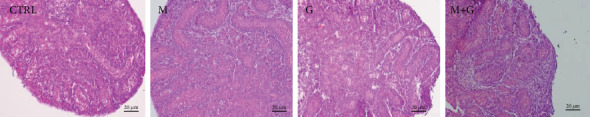
H&E staining of fetal testis cultured for 4 days. H&E staining showed an intact testicular structure and normal appearance of seminiferous tubules; no apparent necrosis or vacuole was visible in all groups; formation of tubular lumens was still not observed. 200x magnification. Scale bars indicate 20 μm.